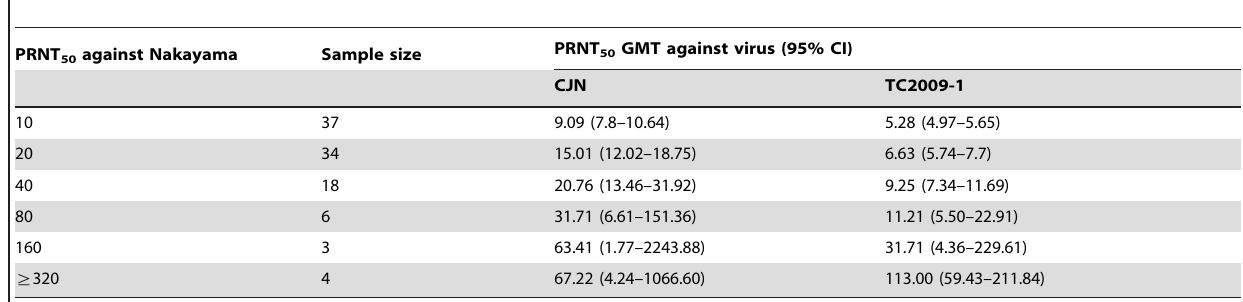
Table 2. Strain-specific protection threshold of inactivated Nakayama Japanese encephalitis virus vaccine.